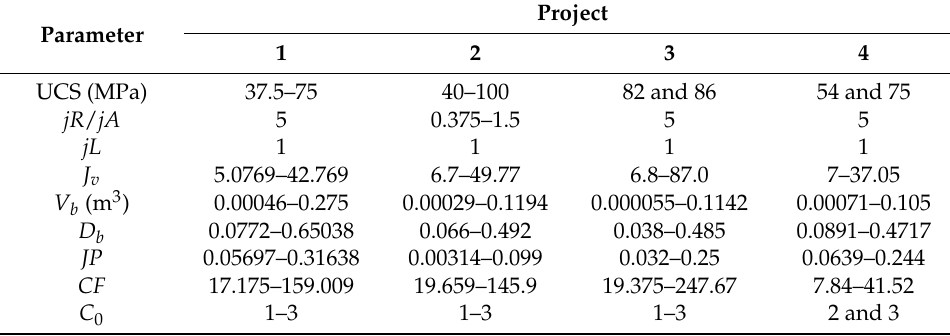
Table 5. Ground conditions ( G c ) and size ratios ( S r ) for all of the tunnel sections of the four